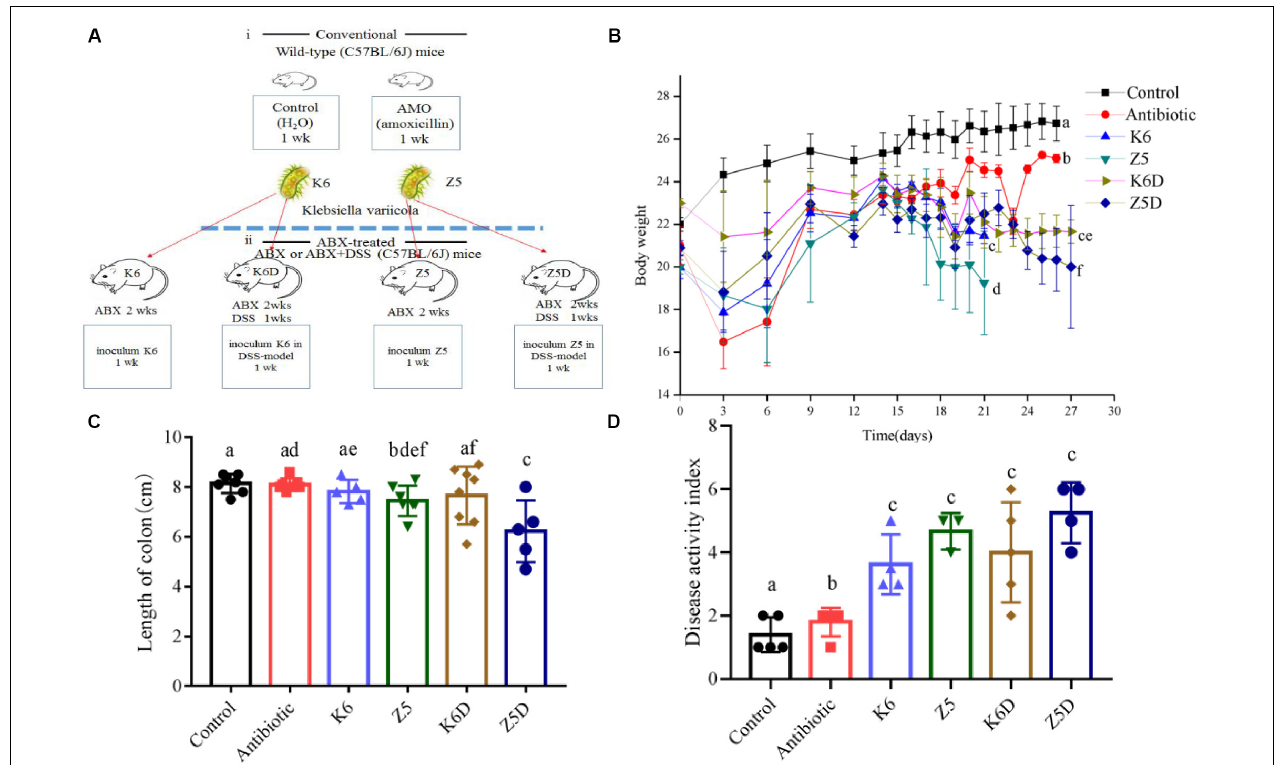
FIGURE 3 | Increased proinflammation in colonized AMO-resistant K. variicola in ABx-treated or DSS-induced colitis mice. (A) Experimental design for colonization with each K. variicola strain in the ABx model. (B) Weight loss was reported as the mean ± SD from each group. (C) The length of the colon measured during treatment. (D) Disease activity index. Different letters indicate significant differences ( P < 0.05, one-way ANOVA) between different groups (mean ± SD, n = 3–8 mice per